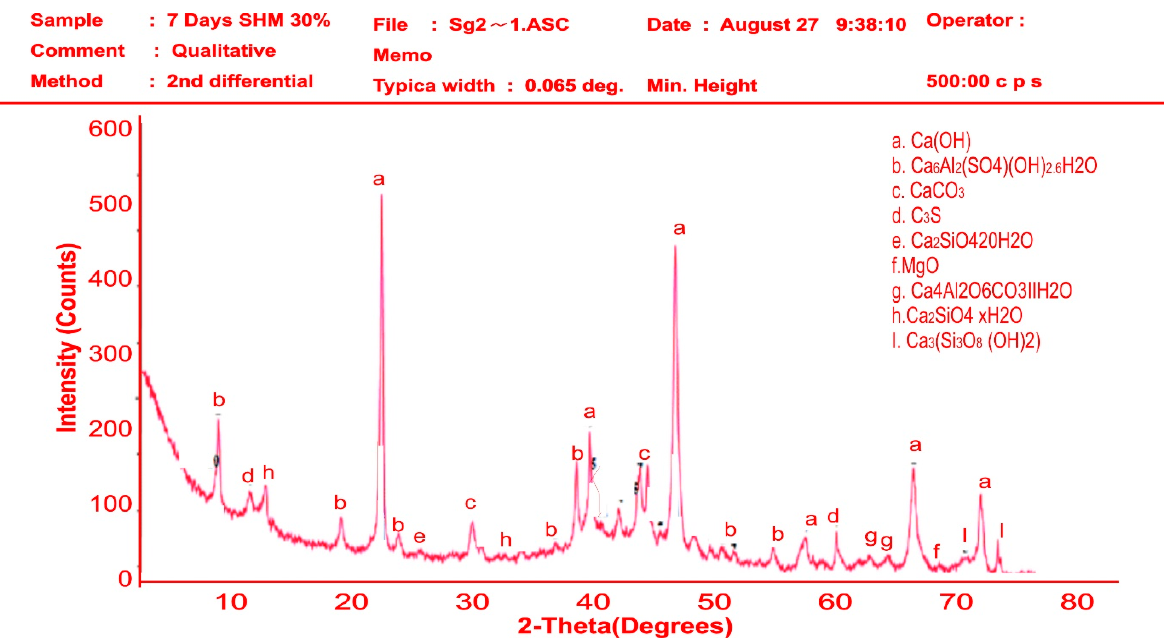
Figure 11. XRD pattern of the hardened control mortar sample at 28 days.